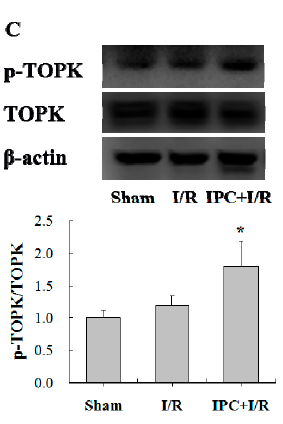
Figure 2. Ischemic preconditioning (IPC) treatment induced upregulation of TOPK in the rat myocardium after 30 min ischemia/3 h reperfusion. ( A ) Representative immunohistochemical staining of TOPK and p-TOPK in the ischemic area of left ventricular (LV) myocardial sections of rats subjected to sham operation, I/R, or IPC+I/R; ( B ) Detection of mRNA levels of TOPK by RT-PCR. GAPDH was used as the loading control; ( C ) Detection and quantitative analysis of TOPK and p-TOPK levels by western blotting. β -actin was used as the loading control. n = 6. * p < 0.05 compared with sham-operation group.